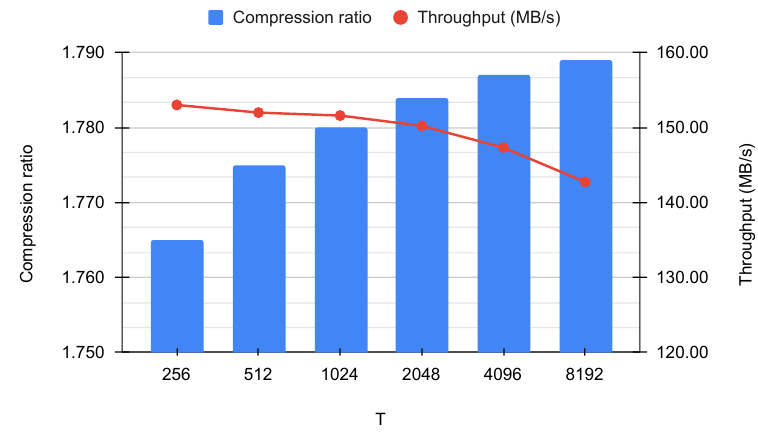
Figure 3. Average compression ratio and throughput (complete dataset) for N = 8192 and different values of T